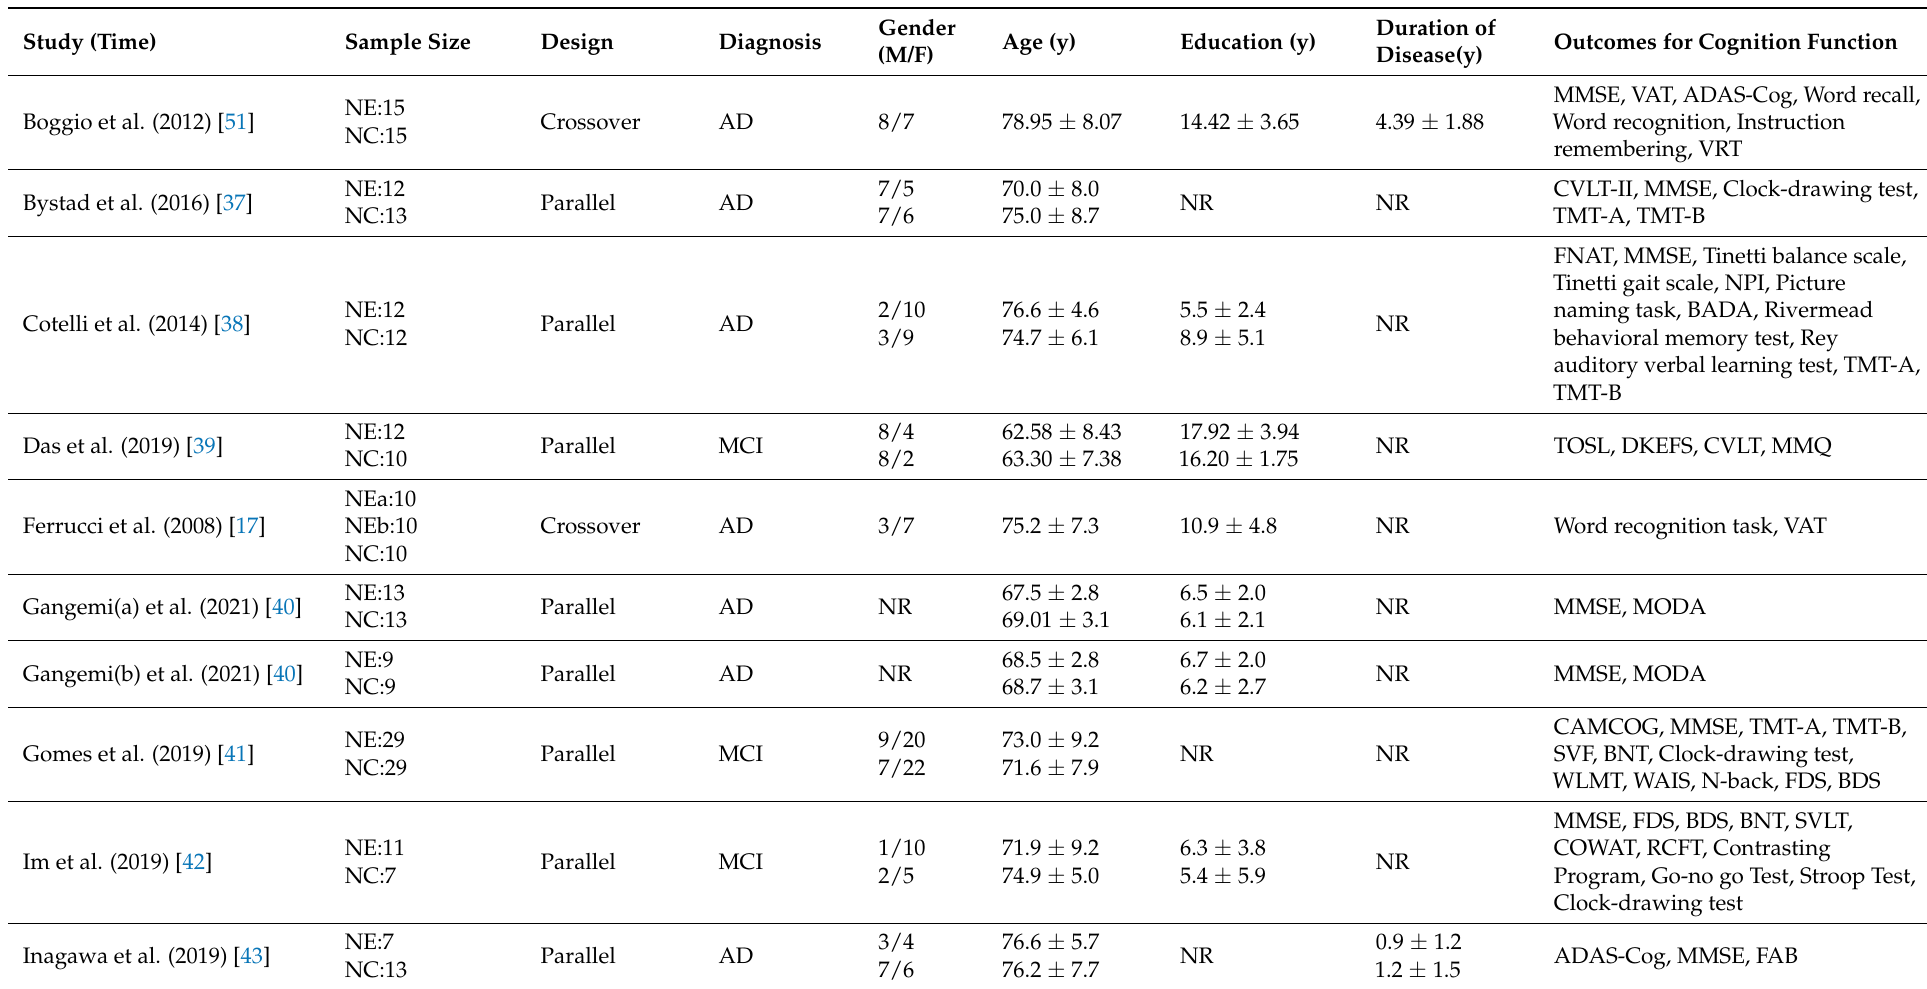
Table 1. The basic characteristics of the included